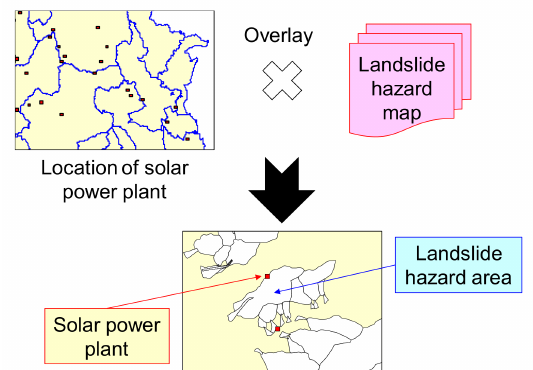
Figure 7. Overlaying mega PV solar plant locations and landslide hazard